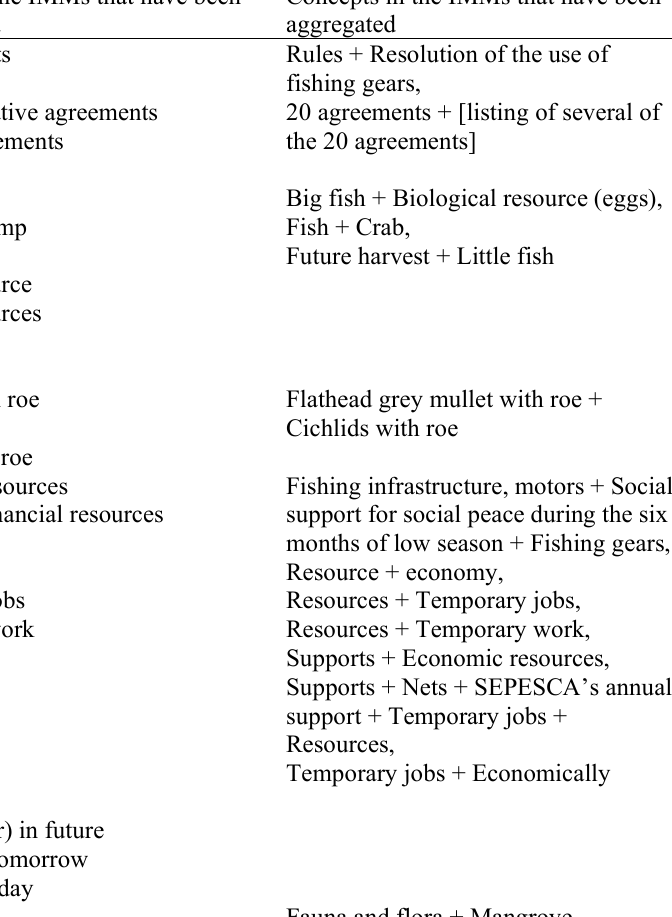
Table A2.2. Qualitative aggregation of resources Final